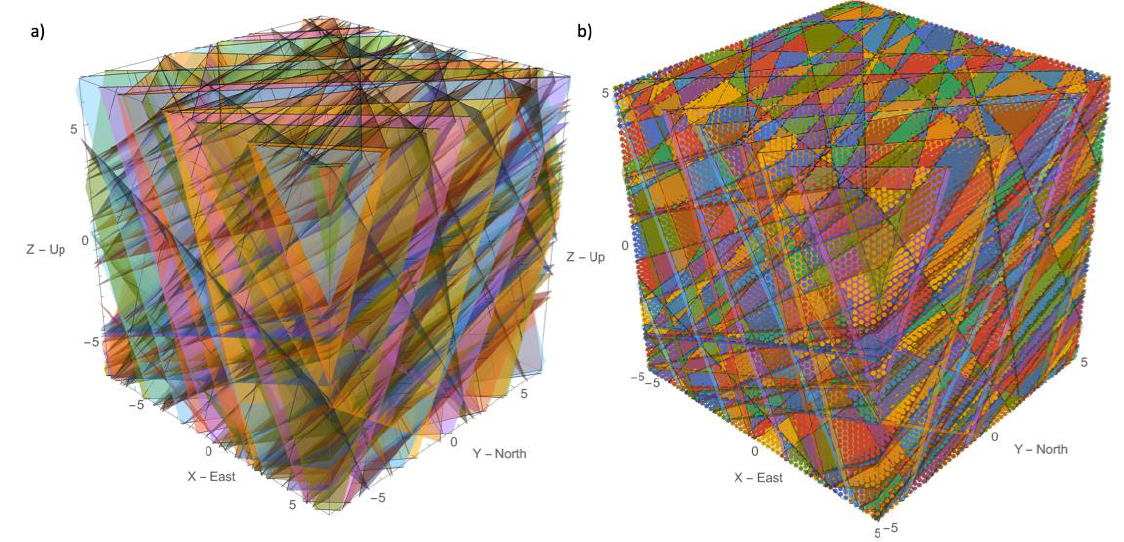
Figure 11. View of one realization of the 10 m × 10 m × 10 m persistent DFN built for Site S042 ( a ) and discrete blocks defined by the DFN, colorized randomly ( b ).